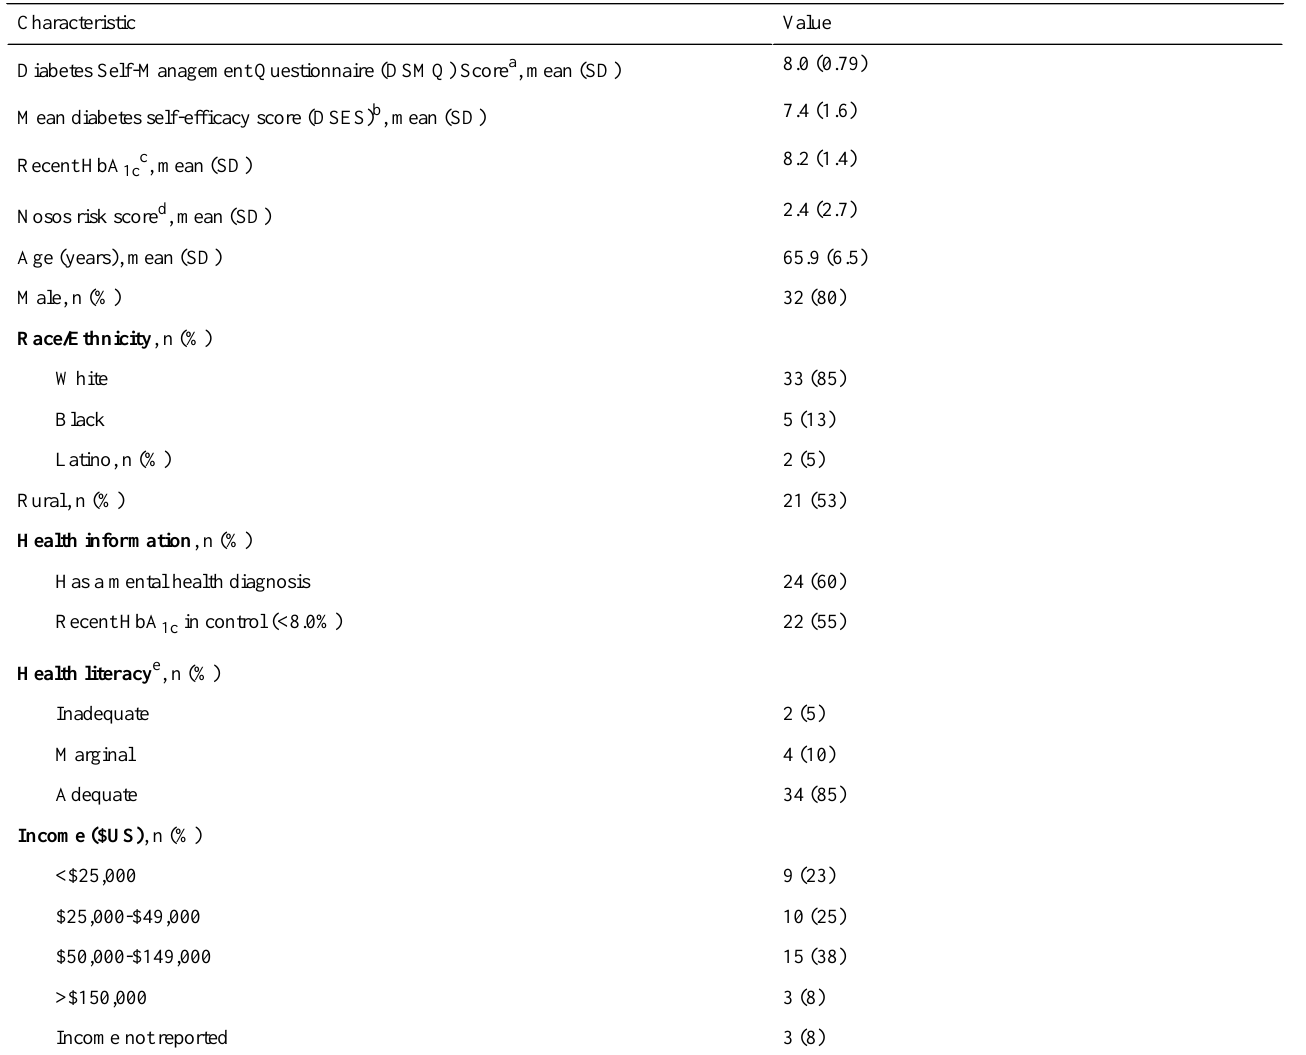
Table 1. Sample characteristics (N=40).